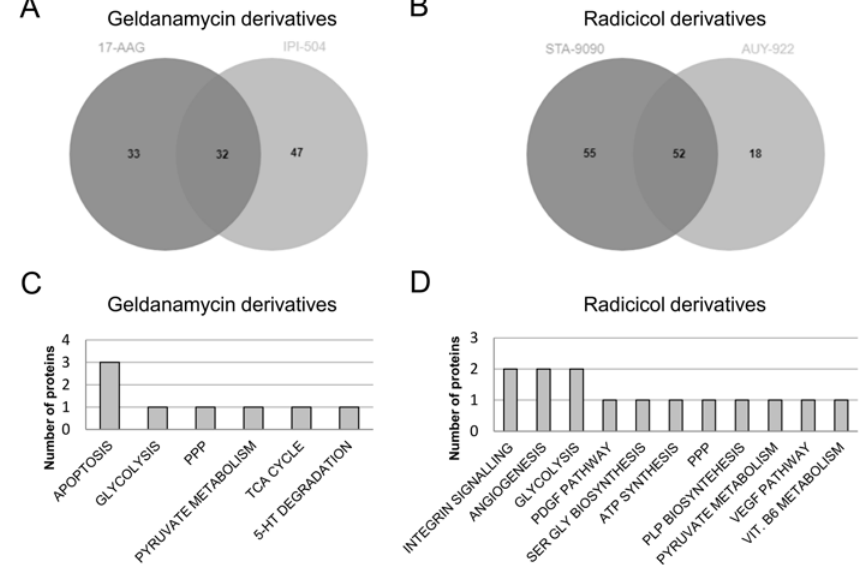
Figure 4. Study of cell line response to HSP90 inhibitors according to inhibitor family. Venn diagrams showing overlap of di ff erentially expressed proteins as well as those specific to inhibition with ( A ) geldanamycin or ( B ) radicicol derivatives. The analysis of shared proteins following ( C ) geldanamycin or ( D ) radicicol treatments was performed with PANTHER software which identified deregulated pathways associated with each HSP90 inhibitor family. The number of proteins involved in each identified pathway is represented on the y axis. PPP = pentose phosphate pathway, TCA cycle = tricarboxylic acid cycle, 5-HT degradation = 5-hydroxytryptamine or serotonin degradation, PDGF pathway = platelet-derived growth factor signaling pathway, SER GLY biosynthesis = serine and glycine biosynthesis, PLP biosynthesis = pyridoxal-5-phosphate biosynthesis, VEGF pathway = vascular endothelial growth factor signaling pathway.